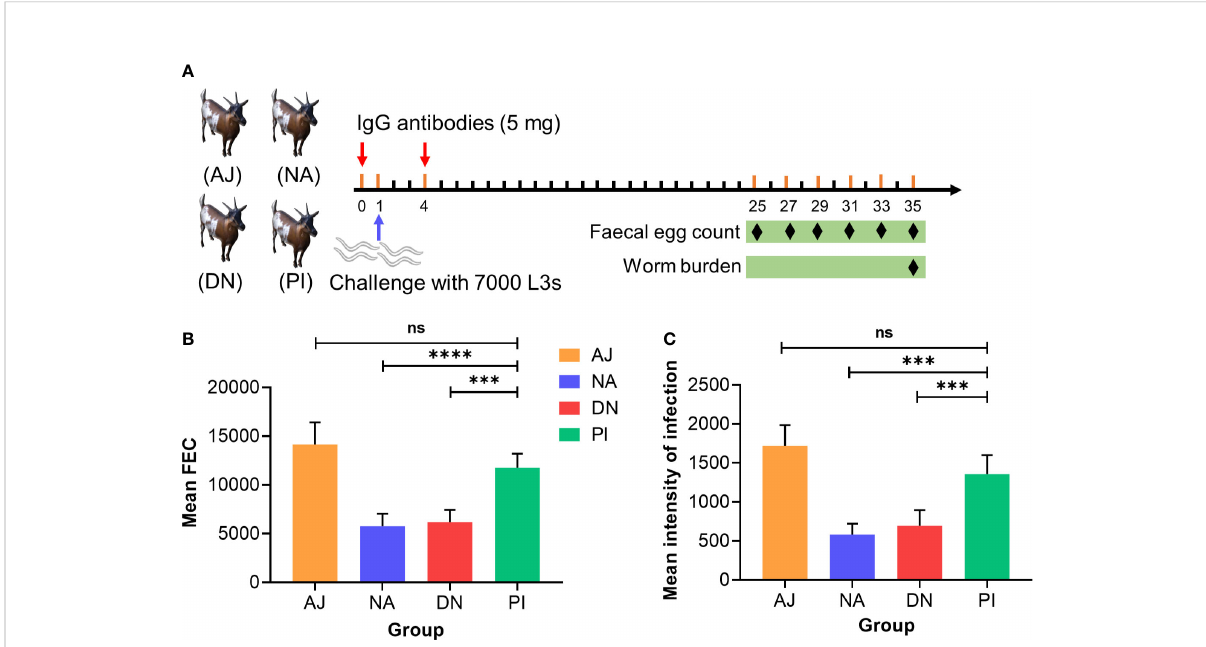
FIGURE 6 Speci fi c anti-H11 IgG antibodies confer the protection in passive immunisation trials against Haemonchus contortus infection. (A) Experiment design of passive animal immunisation. Each of four groups of goats (AJ, n = 4; NA, n = 5; DN, n = 5 and PI, n = 5) received intravenously twice (days 0 and 4, red arrow) IgG antibodies (5 mg) puri fi ed from pooled sera samples (collected on day 42 of the immunisation trial, cf. Figure 4A) from individual animal groups, and infected with 7000 infective third-stage larvae (L3s) on day 1 of the experiment (blue arrow). The numbers of eggs per gram faecal sample (faecal egg count, FEC) were microscopically counted at six time points (days 25, 27, 29, 31, 33 and 35, black diamond) and worm burden was counted at the end of the experiment (day 35, black diamond). (B) Mean group FEC (mean ± SD; AJ, n = 4; NA, n = 5; DN, n = 5 and PI, n = 5) was calculated by the cumulative FEC of each goat. (C) Mean group worm burden (mean ± SD; AJ, n = 4; NA, n = 5; DN, n = 5 and PI, n = 5) was counted by the numbers of adult worms of each goat. Statistical signi fi cance was determined using one-way ANOVA and indicated by asterisks, *** p < 0.001, **** p < 0.0001 and ns (not signi fi